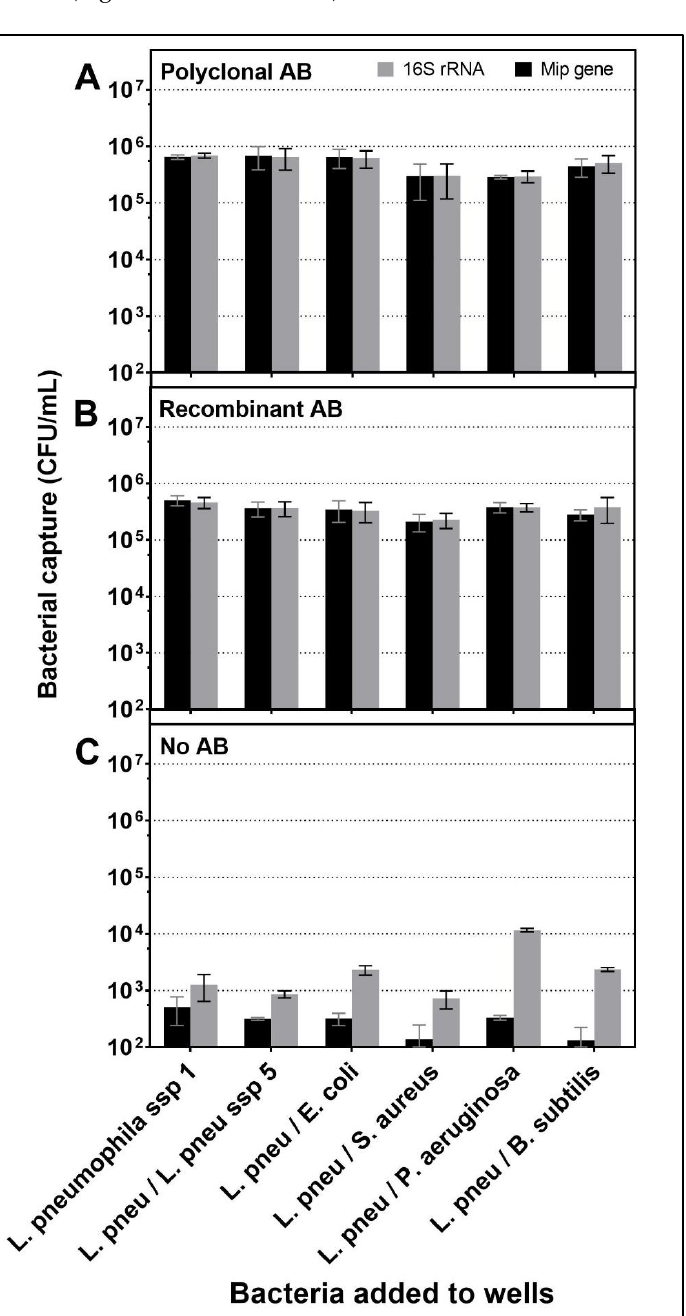
Figure 5. Bacteria captured in wells coated with ( A ) pAb, ( B ) recAb, and ( C ) control no Ab, exposed to various suspensions of live bacteria. L. pneumophila ssp1 at 10 7 CFU/mL was used alone or mixed with other bacteria at 10 7 CFU/mL for E. coli, S. aureus, L. pneumophila ssp5 (ratio 1:1) and 10 6 CFU/mL for B. subtilis and P. aeruginosa (Ratio 10:1) mix ( n = 3). Capture was quantified by qPCR with 16S rDNA universal primers (grey) or MIP primers (black). Error bars are shown to indicate standard deviation.